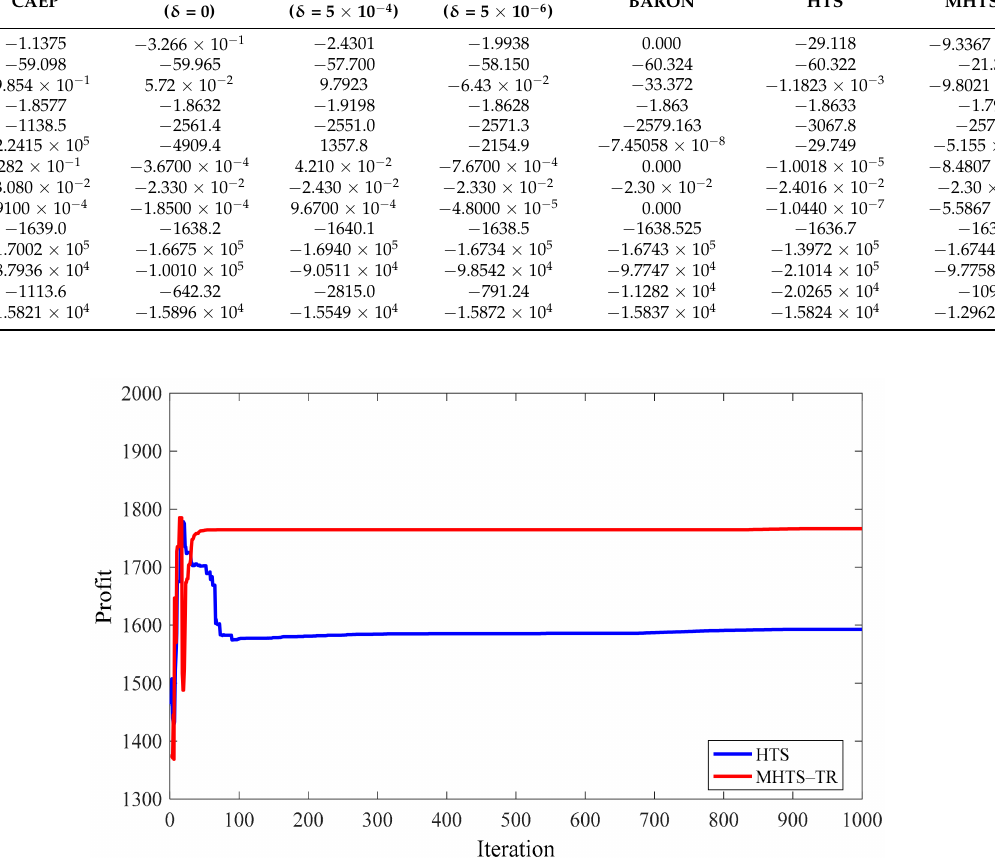
Figure 7. Convergence graph of the original HTS and MHTS–TR algorithms for the simplified alkylation